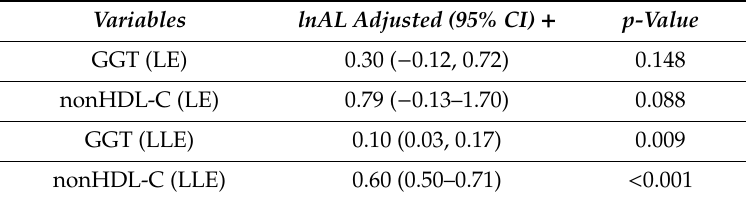
Table 3. Simple linear regression—relationship of AL with cardiovascular-markers in lead-exposed (LE) individuals and less lead-exposed (LLE) individuals at the 5 µ g / dL threshold.